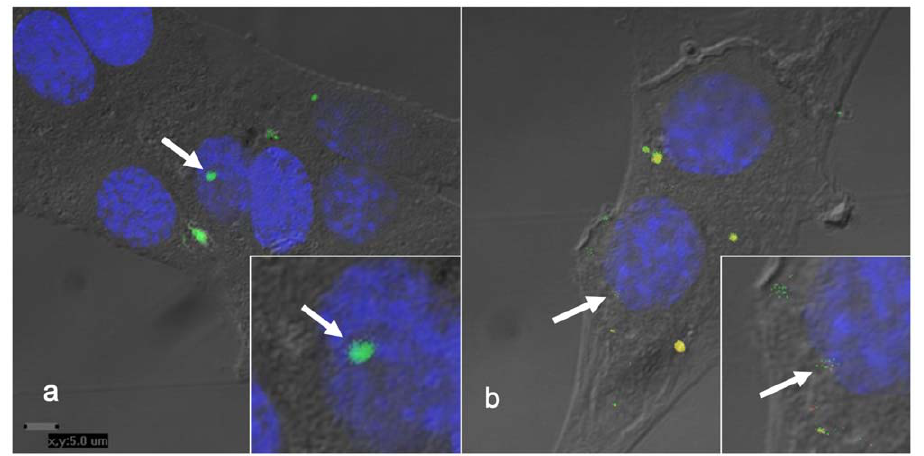
Figure 4. Confocal microscopy images of fibroblasts incubated with microvesicles/exosomes stained with acridine orange. Confocal microscopy picture of DNA-stained microvesicles/exosomes after dialysis, ultracentrifugation and resuspension in DMEM. After incubation with fibroblasts for 3 h at 37 u C the DNA-staining localizes in fibroblasts to and inside the nuclear membrane. Additional light microscopy was used to add a layer in images to visualize cell borders. Arrows in A) and B) indicate acridine orange staining inside nuclei. B) also visualizes red wave length which detects acridine orange staining for RNA. Yellow staining shows colocalization of DNA and RNA. Figure S2 Biological network of ribosomal genes/pro- teins. Total RNA was prepared from microvesicles/exosomes. Illumina Beadstation was used to identify mRNA. Genes with detection p-value less than 0.01 and signal levels over 50 were considered as significantly detected. The bioinformatic database MetaCore (GeneGo Inc.) was used to analyze the 1520 detected genes in the microvesicles/exosomes. Thirty-five genes coding for proteins in the small and large ribosomal subunit and eight additional genes could be connected in a biological network (red circles). Figure S3 Biological network of mitochondrial genes/ proteins. Total RNA was prepared from microvesicles/exo- somes. Illumina Beadstation was used to identify mRNA. Genes with detection p-value less than 0.01 and signal levels over 50 were considered as significantly detected. The bioinformatic database MetaCore (GeneGo Inc.) was used to analyze the 1520 detected genes in the microvesicles/exosomes. Thirty-three genes coding for proteins in the mitochondria could be detected (red circles). Table S1 Genes corresponding to DNA sequences detected in exosomes. DNA was prepared by conventional methods. By use of i.a. TDT polymerase, poly A was added at the end of the DNA strand and a cDNA was constructed. This was labelled with biotin and converted to cRNA therewith making it adaptable to a commercial chip. Hybridisation revealed 343 different chromosomal DNA sequences when using a P-value less than 0.01 and a signal power more than 50. Table S2 Interactions between genes/proteins coded by exosomal mRNA. Total RNA was extracted from the microvesicles/exosomes. Genes/proteins (for which identified mRNAs are encoding) were used in the bioinformatic data base and a biological network was drawn. The microvesicles/exosomes contained 1595 detected mRNA of which 1520 also were detected in cardiomyocytes. Out of these 1520 detected mRNAs in the microvesicles/exosomes, 423 could be directly connected to a biological network without addition of any extra genes/proteins.